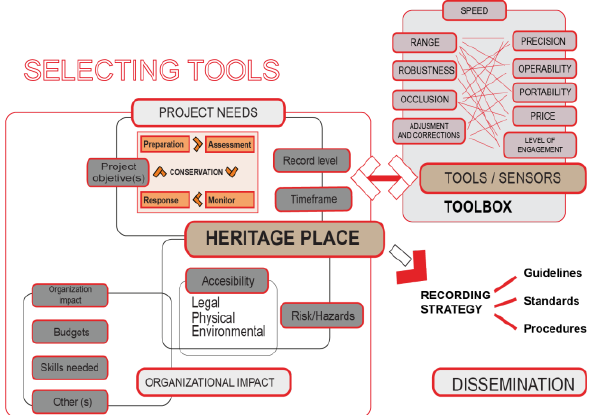
Figure 6: toolbox variables.